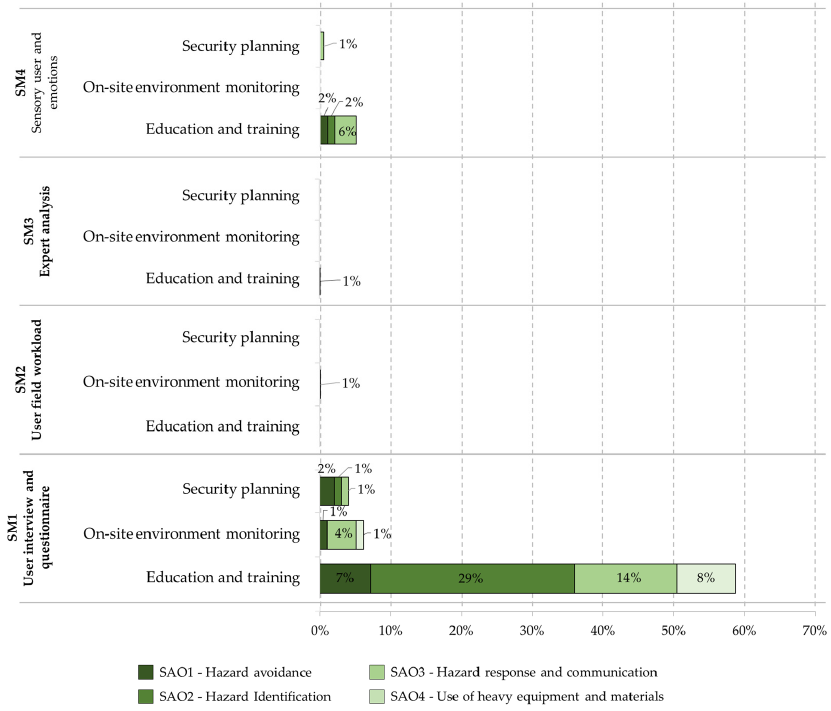
Figure 11. Number of items of each security application objective for each purpose related to the types of evaluation of the subjective method: User interview and questionnaire; User field workload; Expert analysis; and Sensory user and emotions.